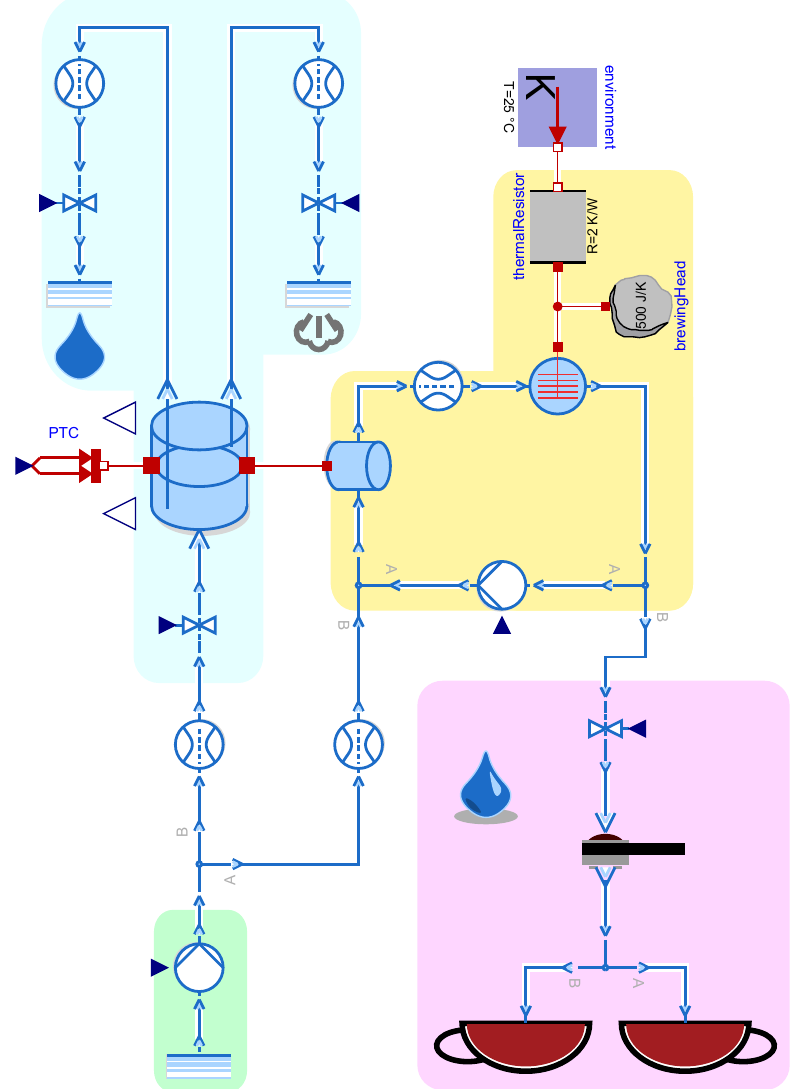
Figure 7. Example of a model with individualized component models. This model simulates an espresso machine composed of water source and pump (green); boiler, water, and steam outlets (blue); brewing head with cycling water (yellow); and valve, coffee strainer, and cups (magenta). Cold water enters the machine through a source at atmospheric pressure and becomes pressurized by a pump to 8.5 bar. Part of the water goes through a control valve into a boiler, where the pressure is regulated by heating through a PTC and the water level is controlled by the valve. For this purpose, the boiler outputs both of these quantities. From the boiler, steam or boiling water can exit if the corresponding valve is opened. The boiler is in thermal contact to a secondary small volume from which water cycles to the brewing head and back, heating up the brewing head. If the machine is at temperature, the valve in front of the coffee strainer is opened and water flows from the pump into the cups, picking up heat in the secondary volume and the brewing head.